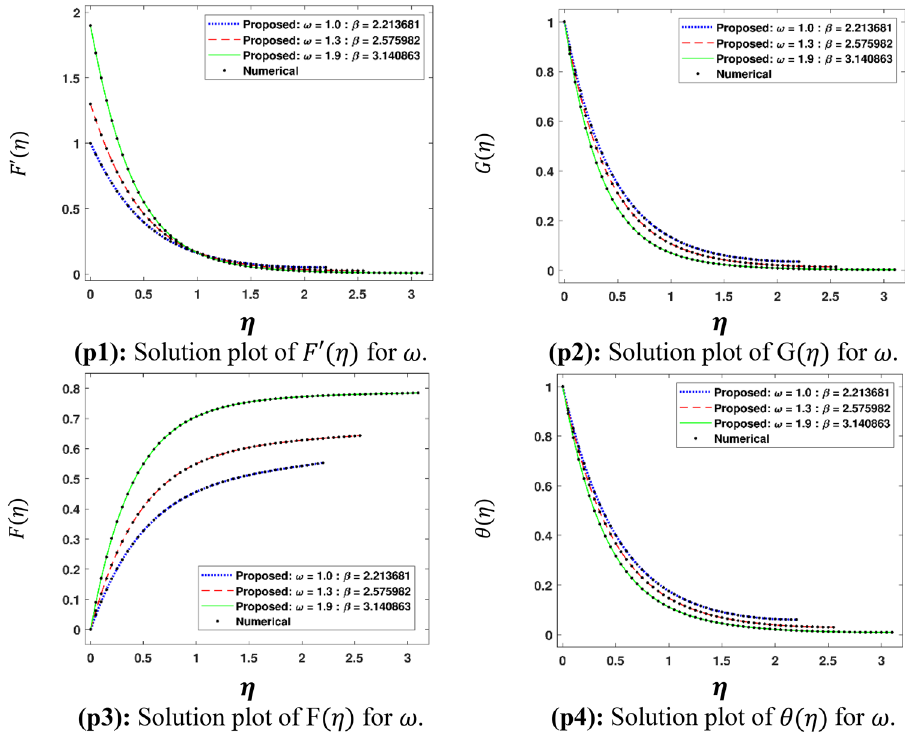
Figure 10. Solution plots of F ′ (η) , G (η) , F (η) and θ(η) by using the proposed scheme.